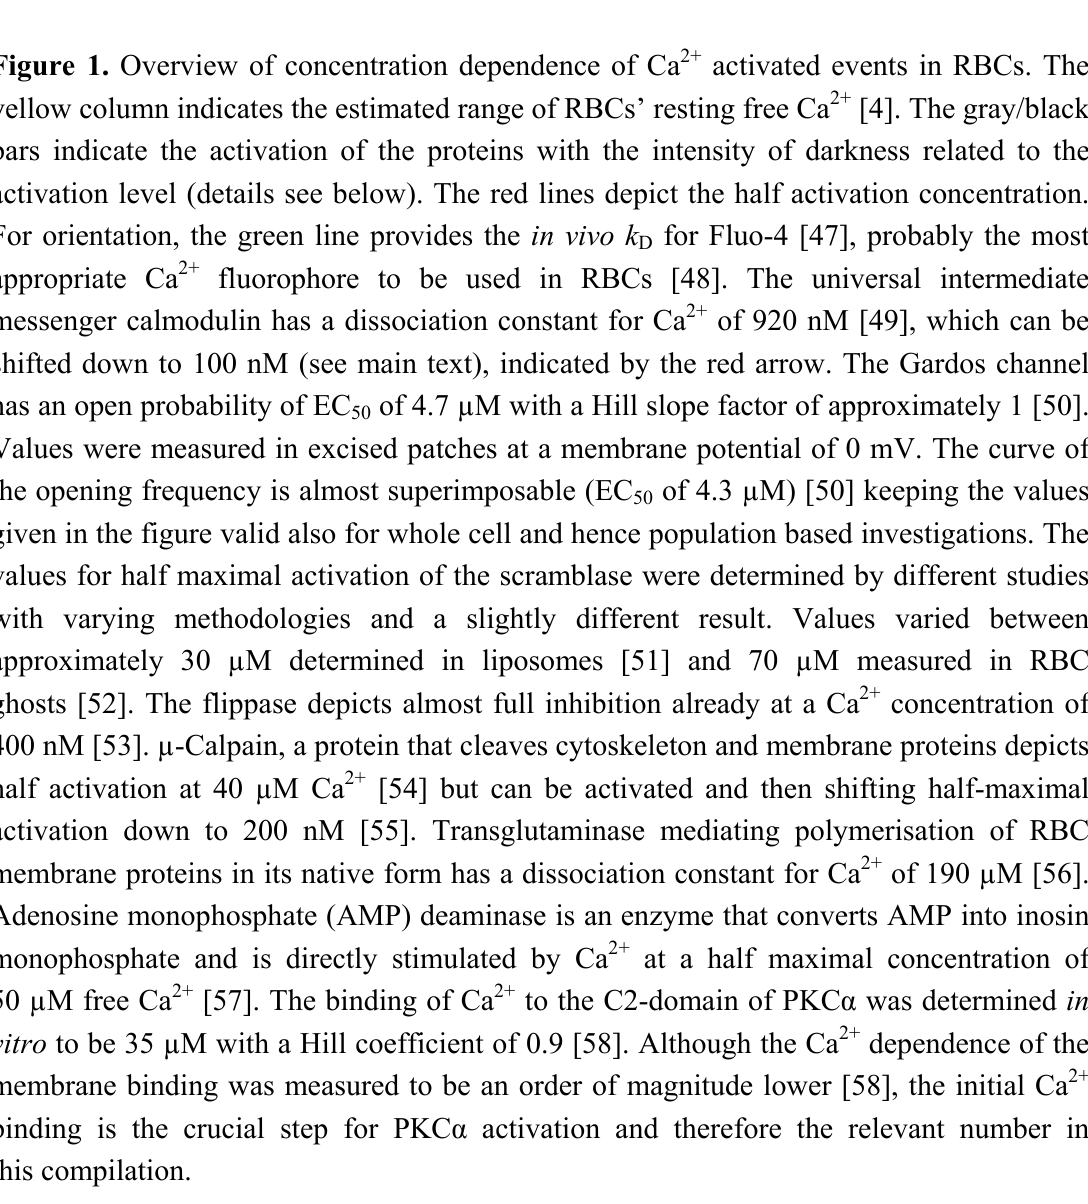
Figure 1. Overview of concentration dependence of Ca 2+ activated events in RBCs. The yellow column indicates the estimated range of RBCs’ resting free Ca 2+ [4]. The gray/black bars indicate the activation of the proteins with the intensity of darkness related to the activation level (details see below). The red lines depict the half activation